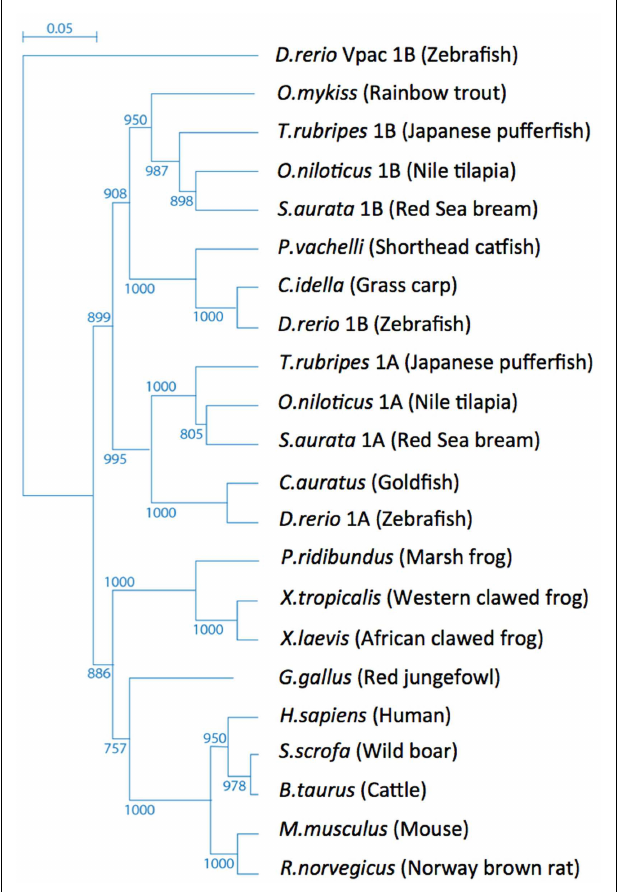
FIGURE 1 |Tree topology of the vertebrate PAC1 receptor family . Phylogenetic relationships of PAC1 receptors analyzed using the zebrafish ( Danio rerio )Vpac1b gene as an